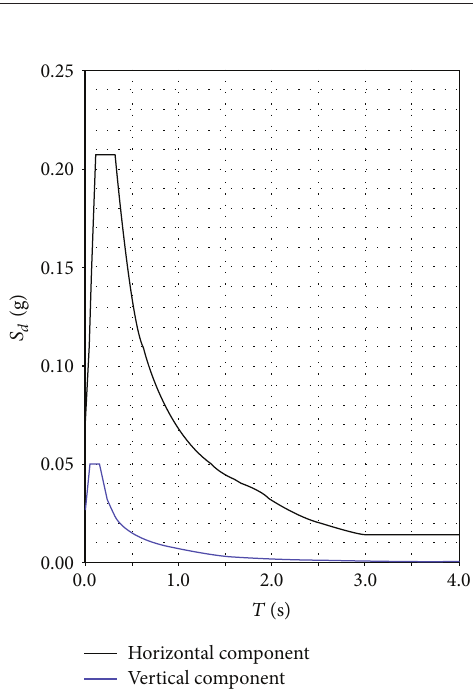
Figure 12: Elastic response spectrum of acceleration Sd (g).